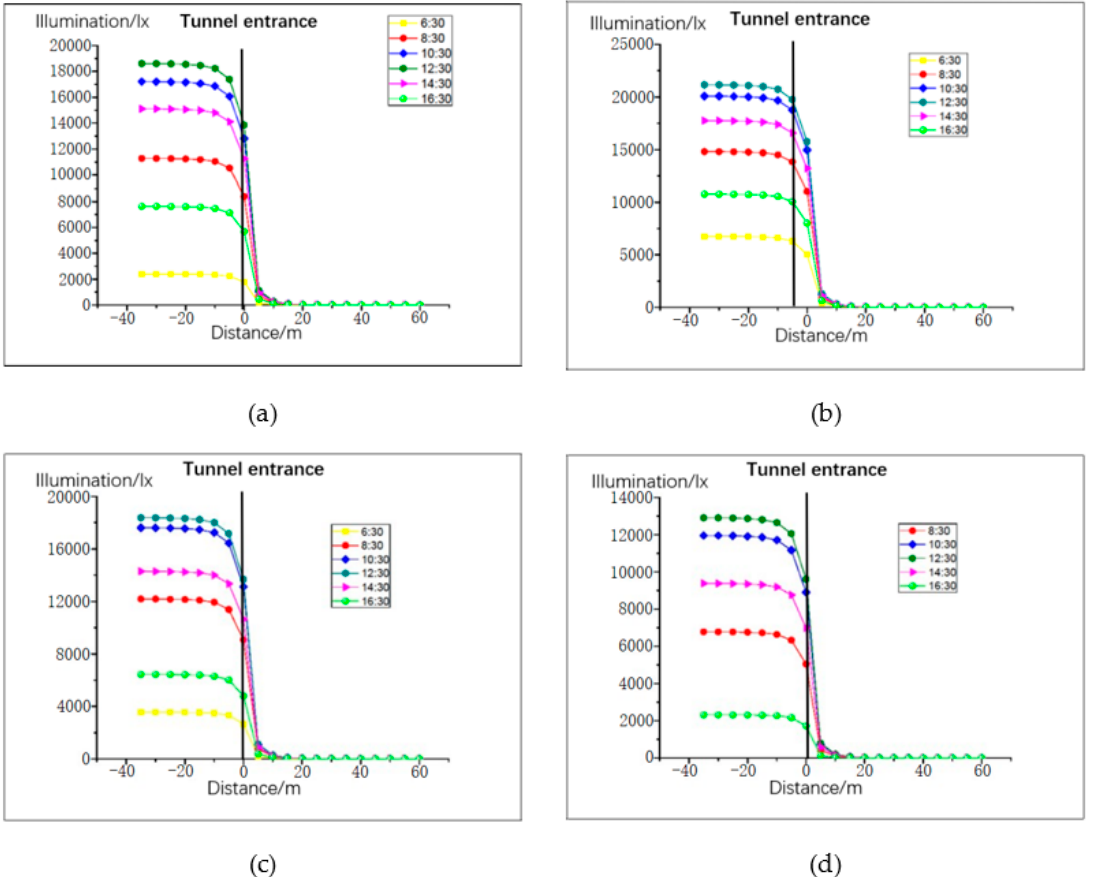
Figure 5. Road illumination for cloudy weather pattern: ( a ) vernal equinox, ( b ) summer solstice, ( c ) autumn equinox, and ( d ) winter solstice.